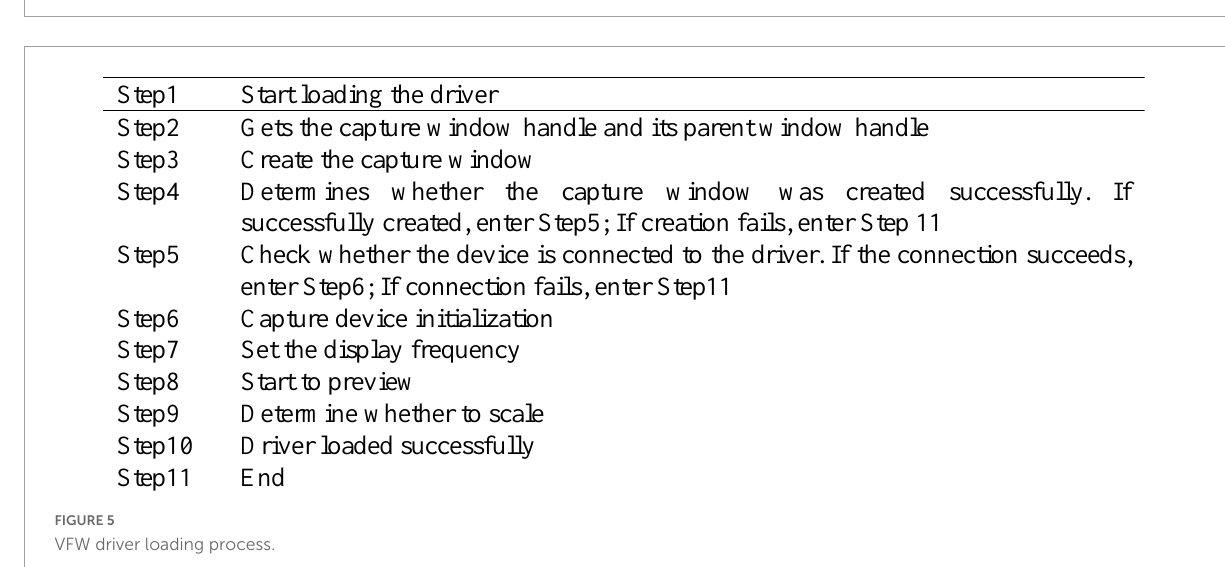
FIGURE4 VFW video capture process.